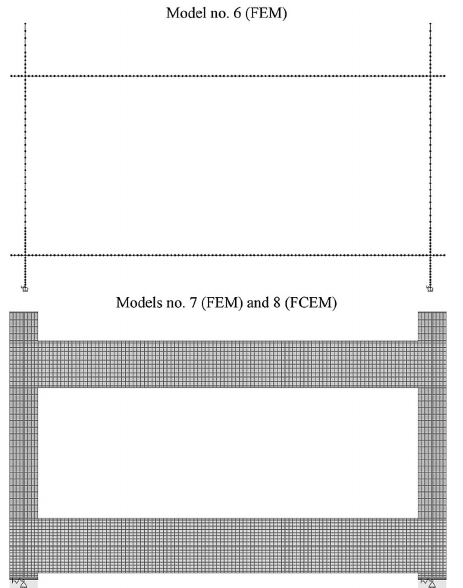
Fig. 6. Steel frame models adopted for the dynamic analysis carried out with FEM and FCEM methods